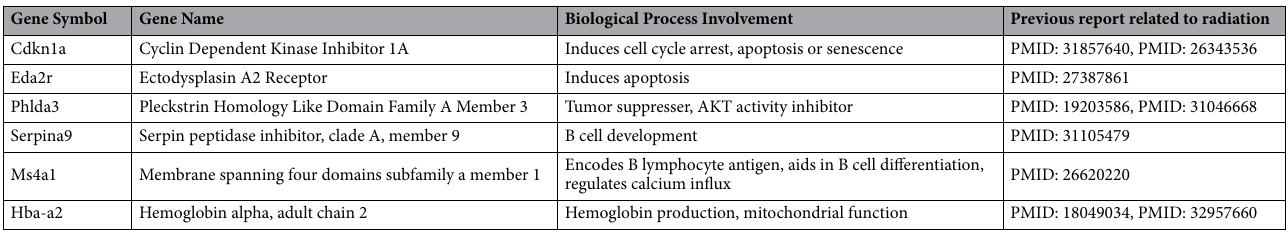
Table 1. Biological roles of most significantly dose-responsive mRNAs. Genes displayed correspond to the top three most significantly dose-responsive up- and down-regulated mRNAs shown in Fig. 1D. A short-list of biological process involvement and previous reports of involvement in the molecular response to radiation are